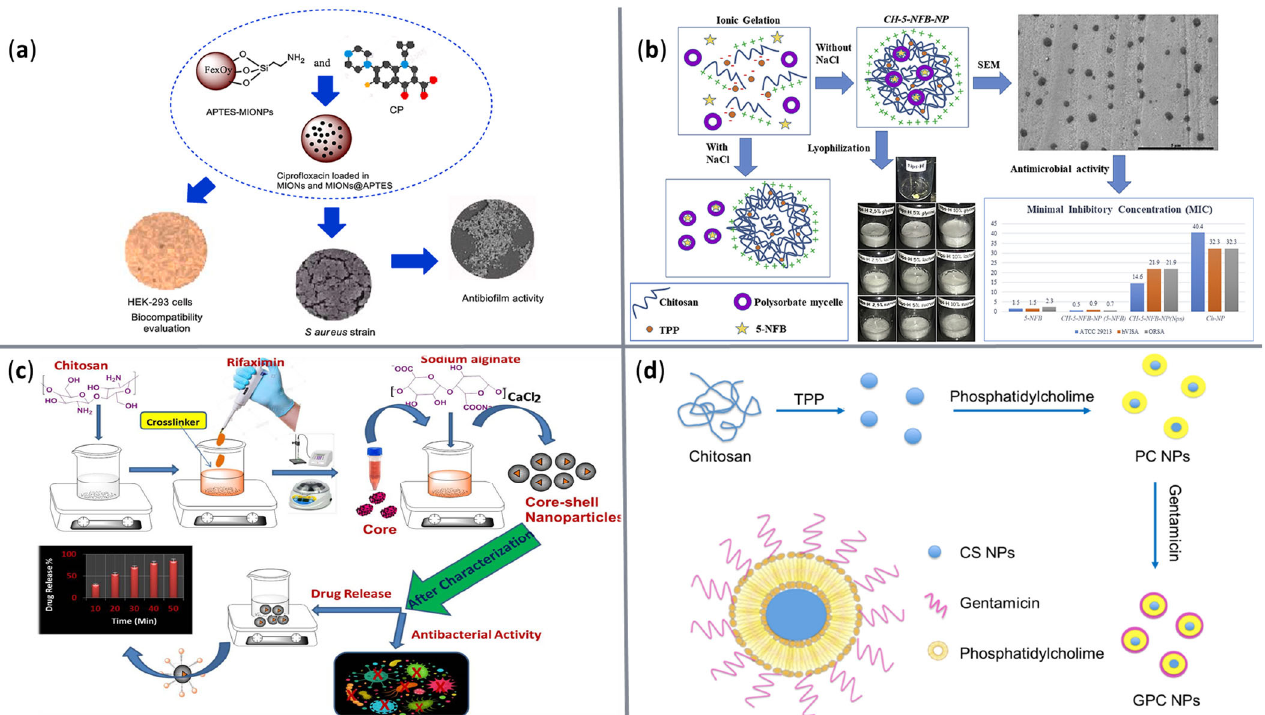
Figure 6. Visual representation of several nanosystems for antibacterial agents’ delivery. ( a ) Meso ‐